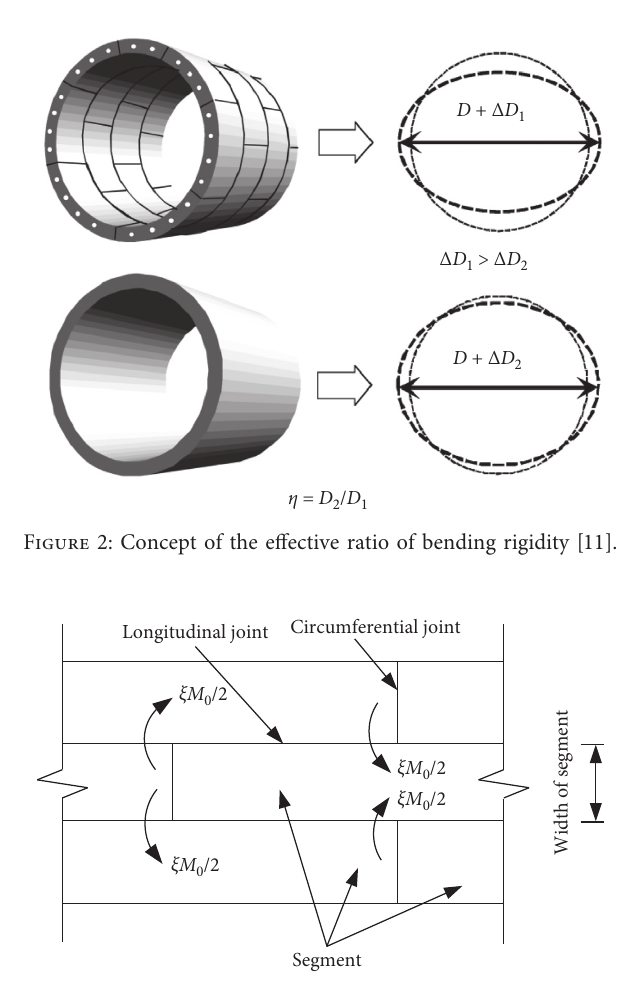
Figure 1: Structural models of the shield segment. (a) Uniform rigidity ring method. (b) Average uniform rigidity ring. (c) Multihinge ring. (d) Beam-spring model.